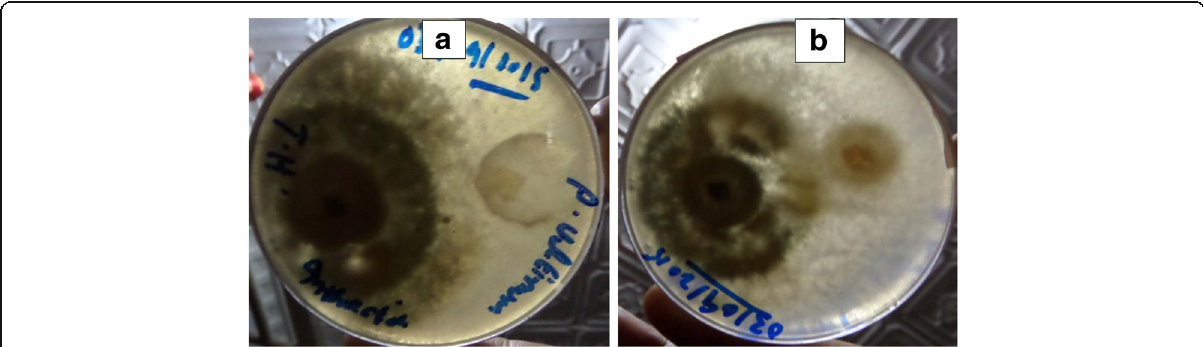
Fig. 1 a Interaction between Trichoderma harzianum and Phythium ultimum. b Interaction between Trichoderma harzianum and Phytopthora capsici